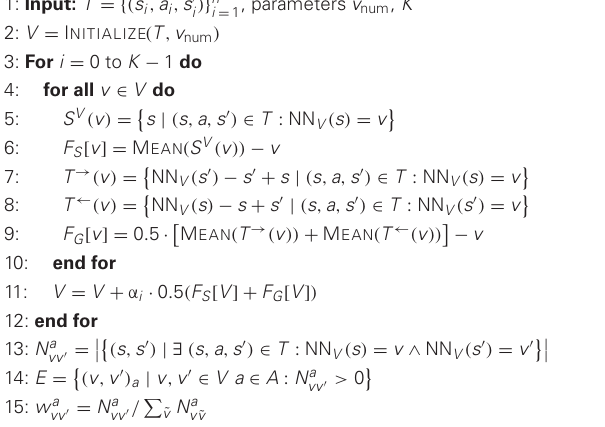
Algorithm 1 | Force-based Iterative Graph Estimation